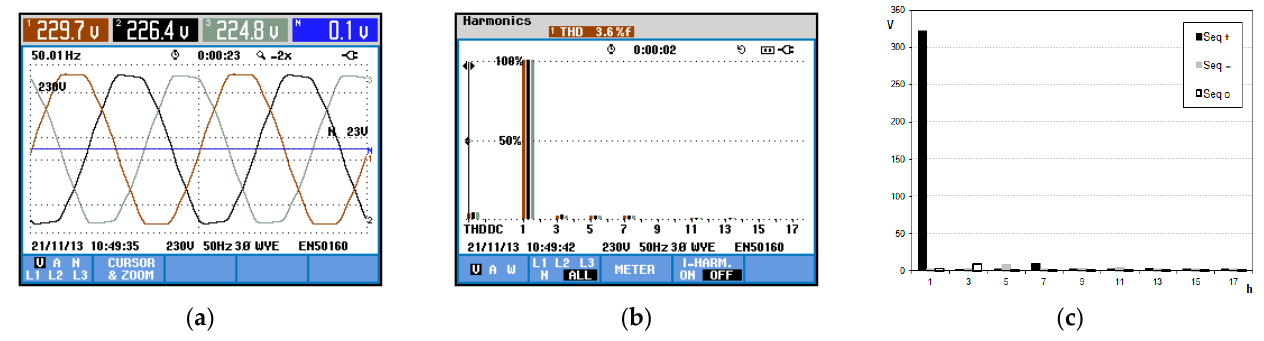
Figure 37. Without filters with unbalanced loads: ( a ) three-phase voltages; ( b ) harmonic spectrum of the voltages; ( c ) harmonic spectrum of the voltage sequence components (maximum values).